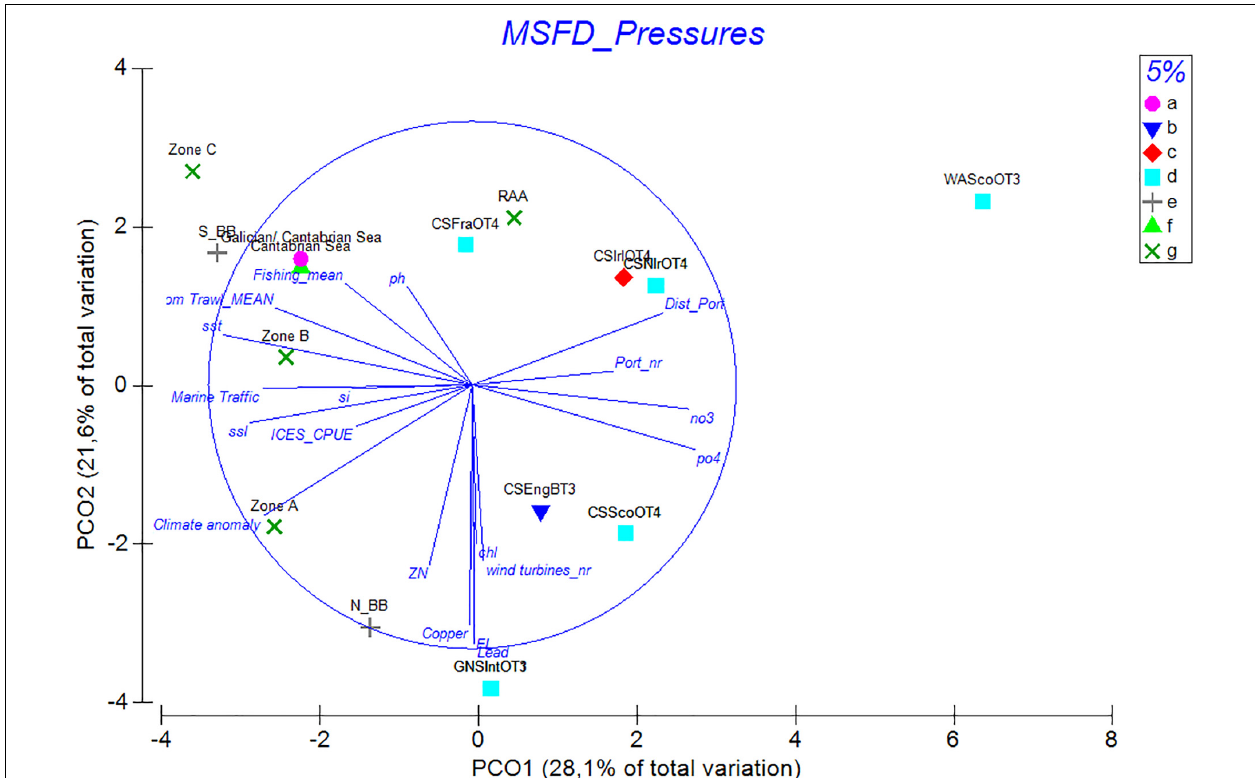
FIGURE 6 | Principal coordinates analysis (PCO) for the anthropogenic pressures’ variables identified in Table 2 . Clusters as obtained in the cluster analysis represented in Figure 4A